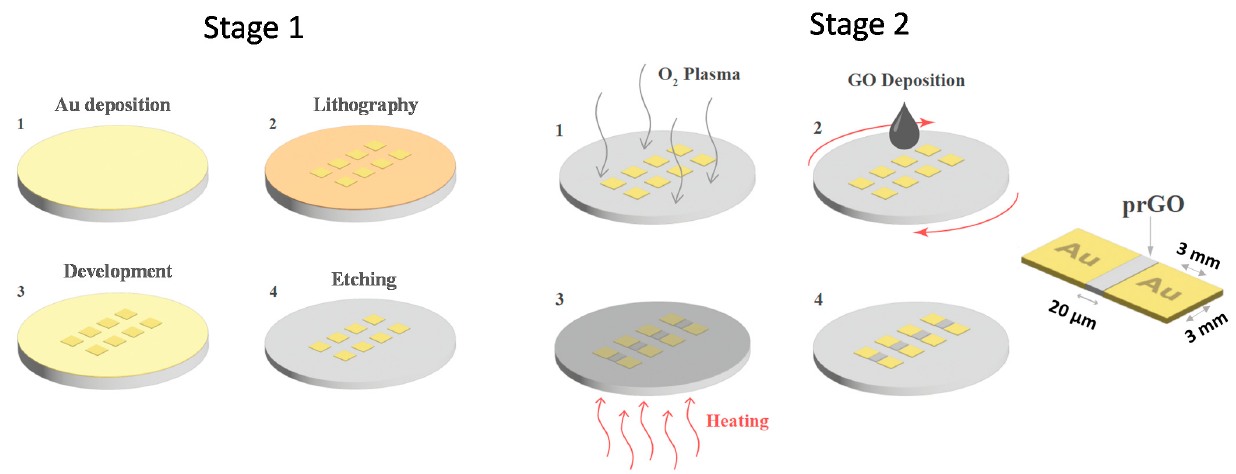
Figure 1. Memristor device fabrication steps. Stage 1 includes the patterning of the gold electrodes, while Stage 2 involves the deposition of the GO layers between the planar